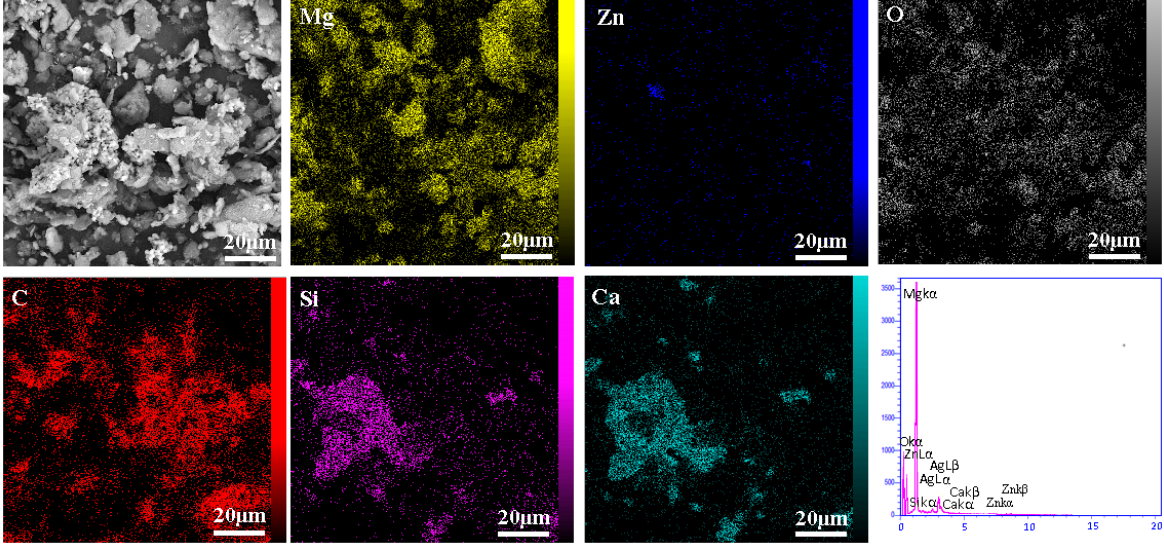
Figure 3. SEM and EDS (map and point) spectra of composite